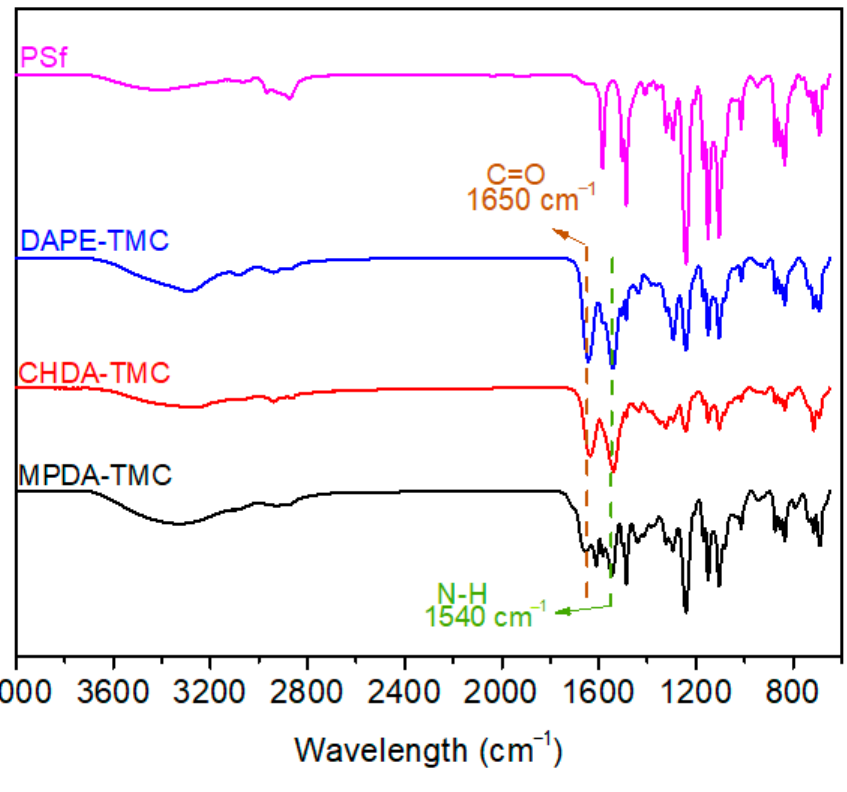
Figure 3. ATR-FTIR spectra of PSf support and TFC membranes.